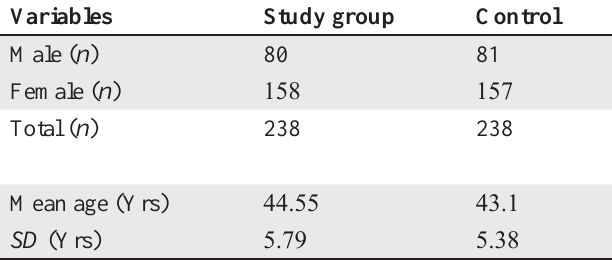
Table 1 : Demographic details of participants